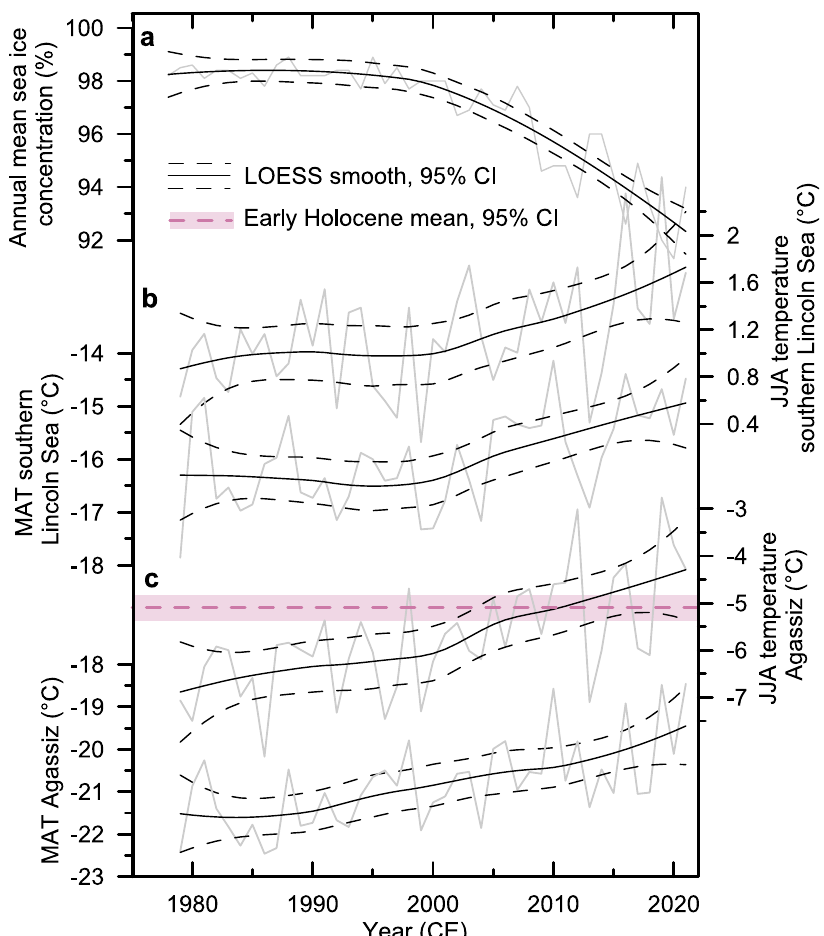
Fig. 3 Modern sea-ice, mean annual and summer temperatures in the southern Lincoln Sea region. a Annual mean sea-ice concentration in the southern Lincoln Sea (grey) including the LOESS (locally weighted scatterplot smoothing) smooth (black) and the 95% con fi dence interval (dashed black) from the Pan-Arctic Ice Ocean Modeling and Assimilation System (PIOMAS), 1978 – 2021 65 . b JJA and mean annual temperatures at a location proximal to 12-GC and 14-GC (82.5 °N, 55 °W, 0 m MSL) from the ERA5 reanalysis (2 m atmospheric temperatures) 64 (light grey) and the respective LOESS smooth (black) including the 95% con fi dence interval (dashed black), 1979 – 2021. c JJA and mean annual temperatures proximal to the Agassiz ice cores (80.75 °N, 73 °W, 1740m MSL) from the ERA5 reanalysis (2 m atmospheric temperatures) 64 (light grey) and the respective LOESS smooth (black) including the 95% con fi dence interval (dashed black), 1979 – 2021. The average of JJA temperatures for the Early Holocene interval characterized by seasonal sea-ice (dashed pink) and the 95% con fi dence interval (light pink) are included in the plot of JJA temperatures at the Agassiz ice